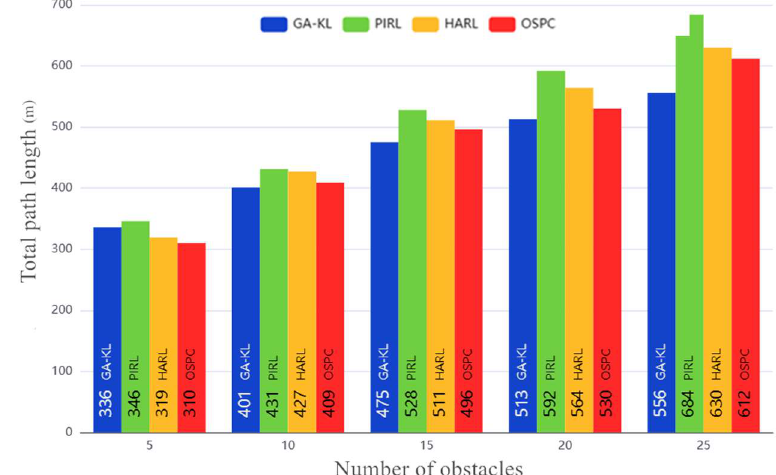
Figure 18. Comparison of total path length.